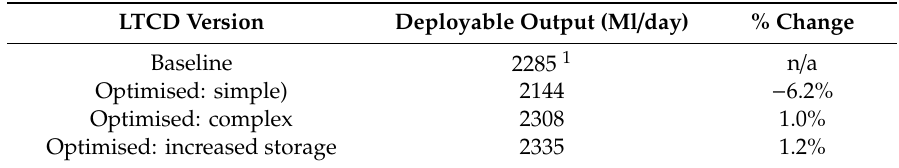
Table 1. Summary of LTCD optimisation results.